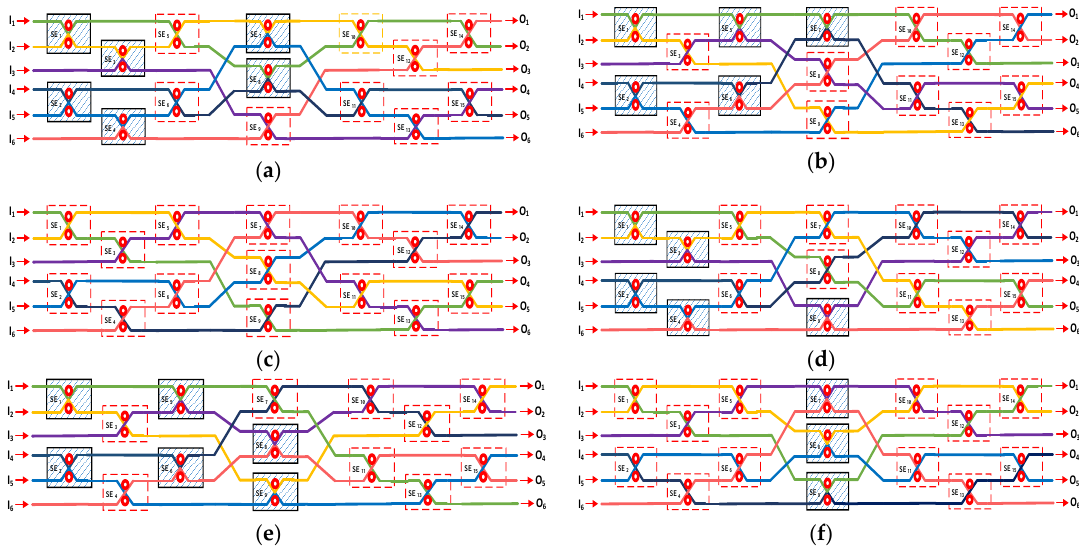
Figure 15. Optimal switching combinations of I/O links in un-optimized HCROS. ( a ) I/O link SC 1 with 6 OSEs in drop/bar state. ( b ) I/O link SC 2 with 5 OSEs in drop/bar state. ( c ) I/O link SC 3 with all OSEs in through/cross state. ( d ) I/O link SC 4 with 5 OSEs in drop/bar state. ( e ) I/O link SC 5 with 6 OSEs in drop/bar state. ( f ) I/O link SC 6 with 3 OSEs in drop/bar state. (Note: all OSEs in drop/bar state are shown in solid line with gradient fill).